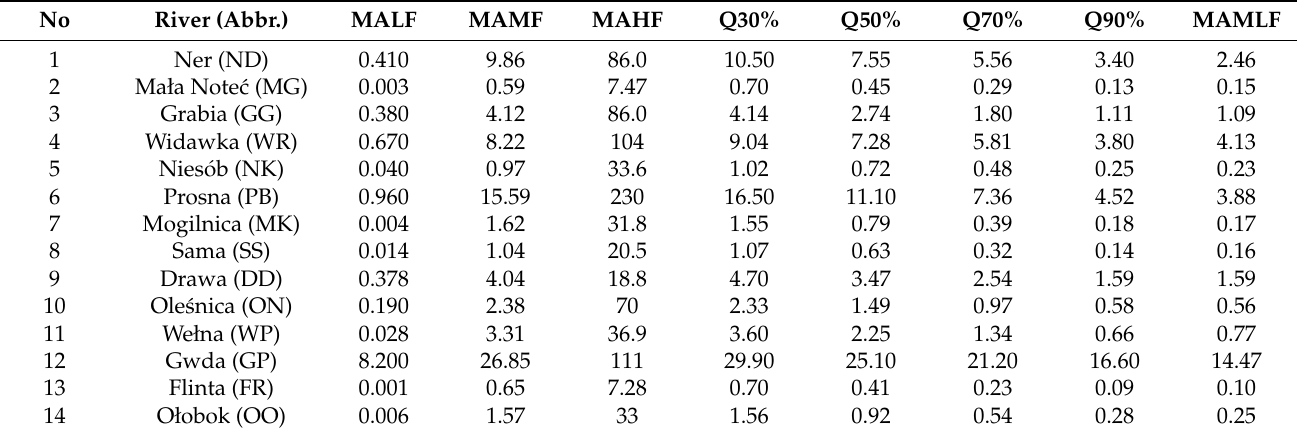
Table 3. Characteristic flows of the analysed